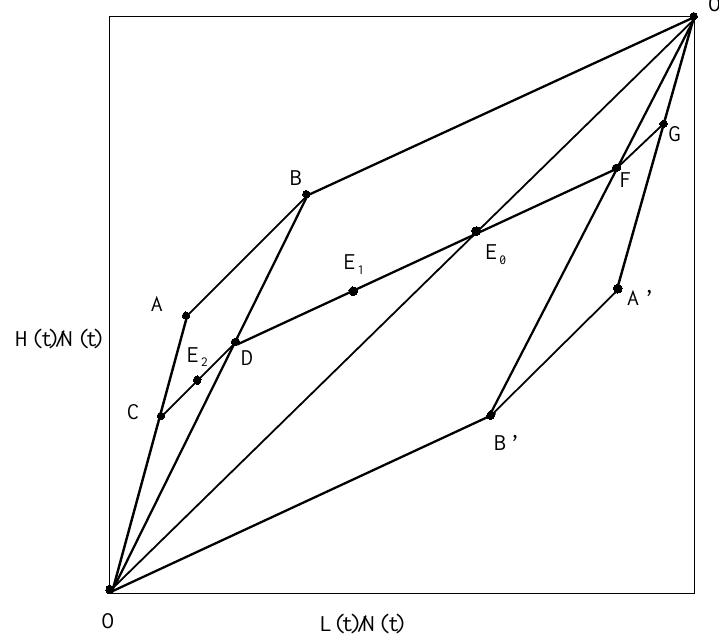
Figure A1. Production Patterns in the Integrated-World